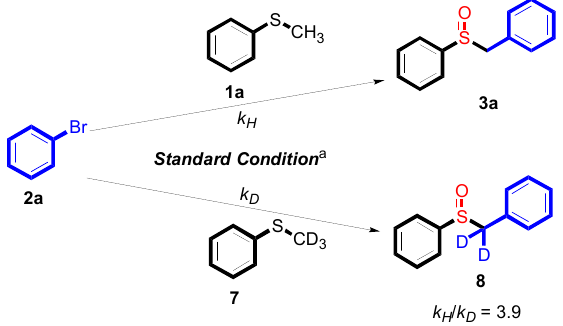
Table 3. Copper-catalyzed sulfoxidation of aromatic methyl thioethers 1 with aryl chlorides 4 a